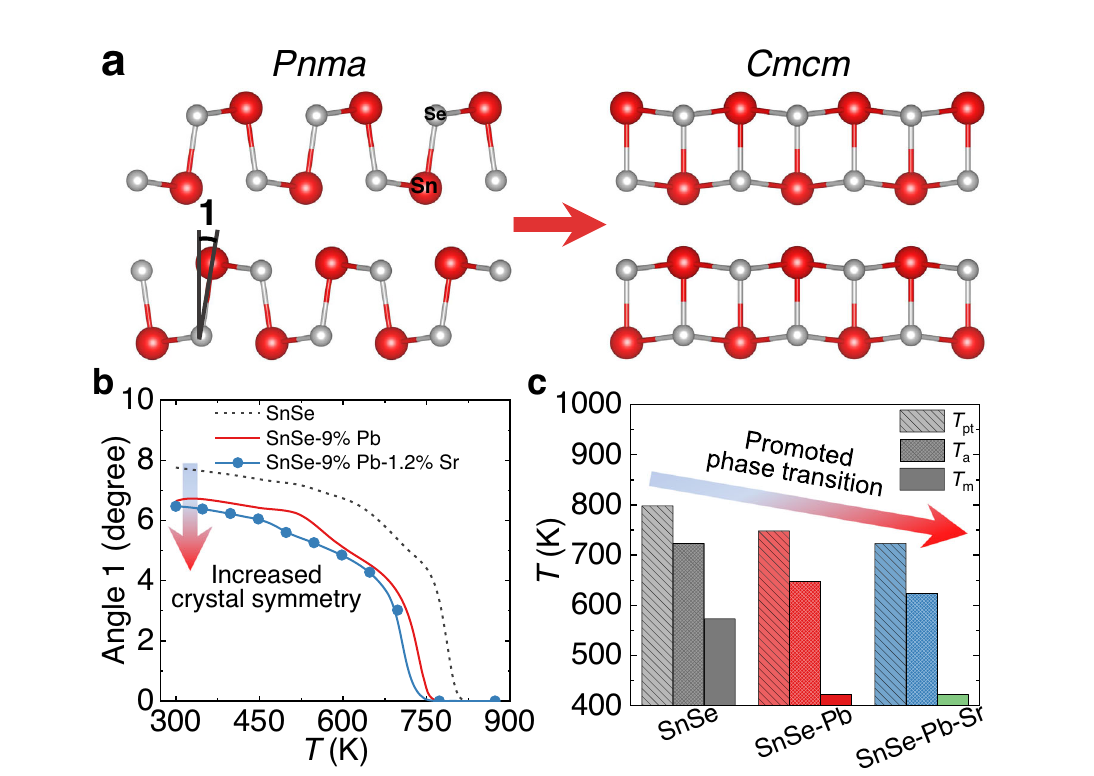
Fig. 3 | SR-XRD measurements and Rietveld re fi nements of p-type SnSe-9%Pb − 1.2%Sr crystal. a Diffraction patterns from 300 to 873K. b Temperature- dependent lattice parameters for hole-doped SnSe, SnSe-9%Pb, and SnSe-9%Pb